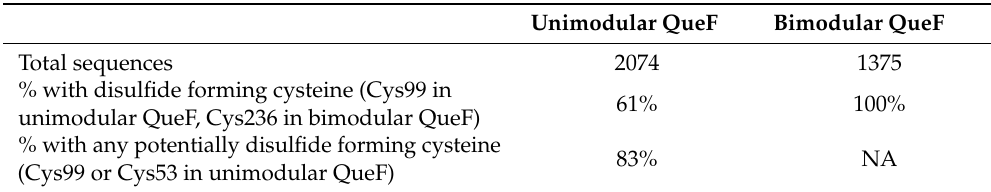
Table 4. Conservation of Cys99 in unimodular QueF and the homologous residue Cys236 in bimodular QueF. NA: Not applicable.